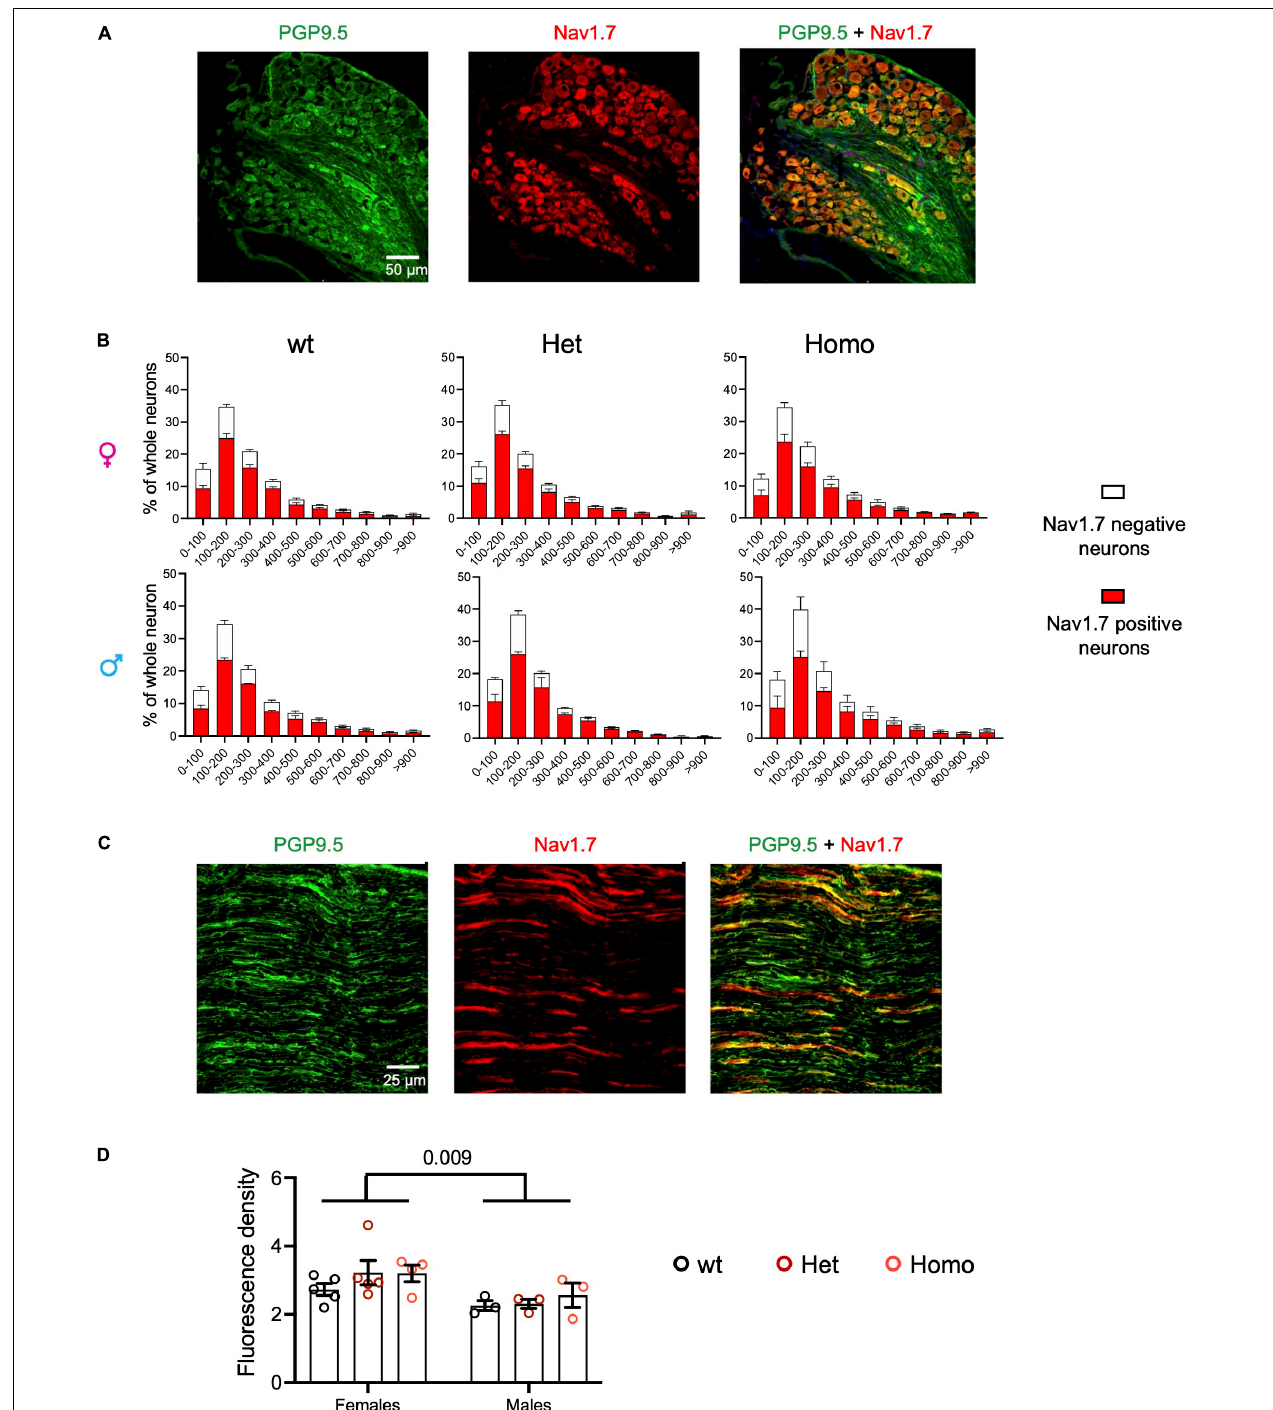
FIGURE 2 | Nav1.7 protein expression of DRG and sciatic nerve in Scn9a R 185 H mutant mice. (A) Representative images of PGP9.5 (green) and Nav1.7 (red) fluorescent immunostaining for all neurons (PGP9.5-positive) and Nav1.7-positive neurons in lumbar DRG of wt animals. Scale bar 50 µ m. (B) Size distribution for Nav1.7-positive (red) and negative (white) neuron cross-sectional areas in wt, het, and homo female and male mice. Females: n = 5/group; male: n = 3/group. Results are shown as means ± SEM. The two-way ANOVAs for genotype and neuron size effects in each sex showed a size effect and no genotype effect. (C) Representative images of fluorescent PGP9.5 (green) and Nav1.7 (red) immunostaining of sciatic nerves of wt animals. Scale bar of 25 µ m. (D) Mean fluorescence density Nav1.7 immunostaining of sciatic nerves in wt, het, and homo female and male mice. Females, n = 4–5/group; males, n = 3/group. Results are shown as means ± SEM. The two-way ANOVA for genotype and sex indicated a sex effect and no genotype effect. The P value of 0.009 is for sex effect. See Supplementary Table 6 for statistics.